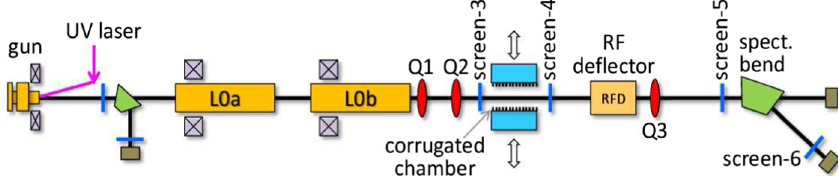
FIG. 3. Layout of the PAL-ITF beam line [2,24]. Two accelerating cavities L0a and L0b are available in the beam line. For this passive deflector experiment, however, L0b was turned off. The corrugated-wall chamber is located between the positions of screen-3 and screen-4, and the RF deflecting cavity is installed after screen-4. Before the spectrometer magnet, screen-5 is inserted, and screen-6 measures the spectrometer